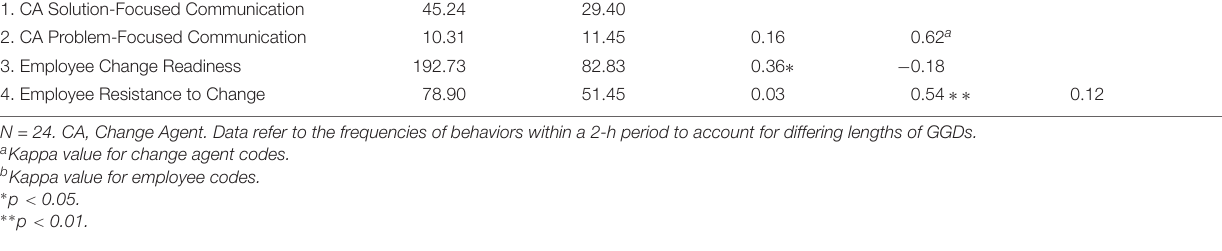
TABLE 2 | Means, standard deviations, and intercorrelations of study variables.